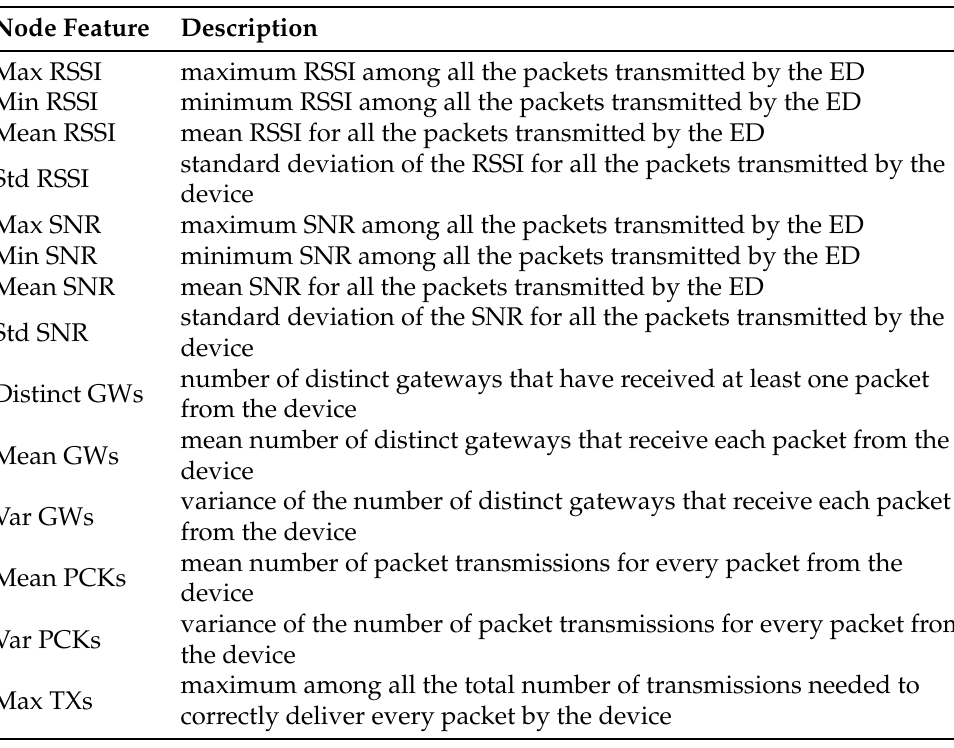
Table 1. Features computed to classify the end nodes in the LoRaWAN